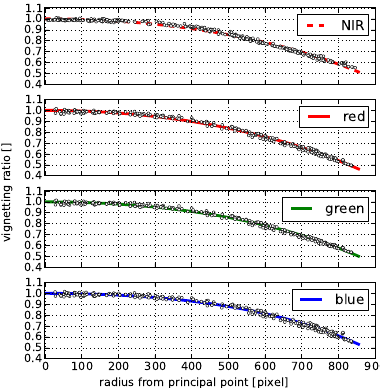
Figure 8: Results of calibration measurement series for each channel. Measurement points from the calibration images and fitted polynomial are plotted against radius from principal point (all data normalized).